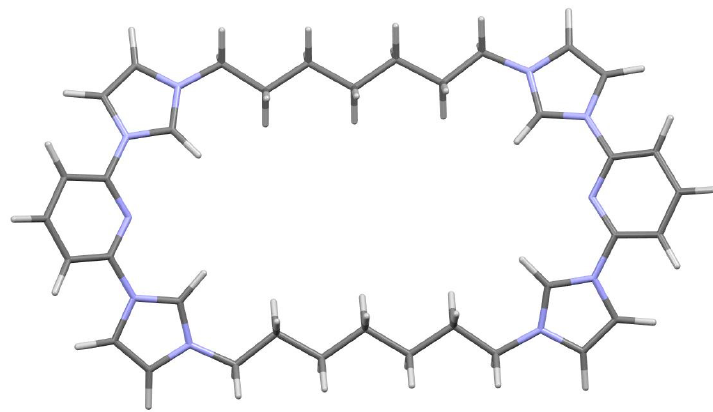
Figure 2. Structure optimization of C7 by DFT/B3LYP/6-31G*.